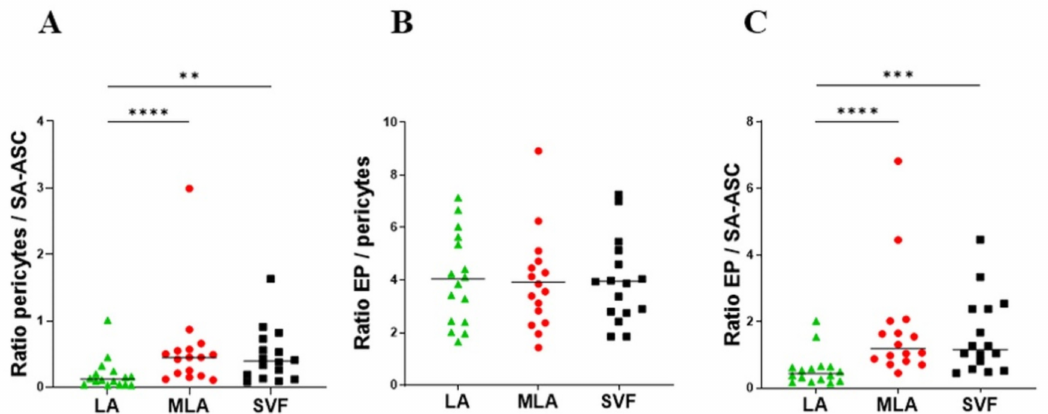
Figure 3. Differences in the ratios of the progenitor cells in the stromal vascular fraction from LA, MLA and SVF samples. The pericyte/SA-ASC ratio ( A ), the EP/pericyte ratio ( B ) and the EP/SA-ASC ratio ( C ) were calculated from the quantitative data shown in Figure 2 (percentage of nucleated cells for each cell population). The data are expressed as symbols representing each patient with the group median ( A , C ) or mean ( B ). Statistical analysis was performed using the Friedman multiple comparisons test ( A , C ) or ordinary one-way ANOVA with Tukey’s multiple comparison test ( B ). p -values: (**) p < 0.01; (***) p < 0.001, (****) p < 0.0001; n = 16.